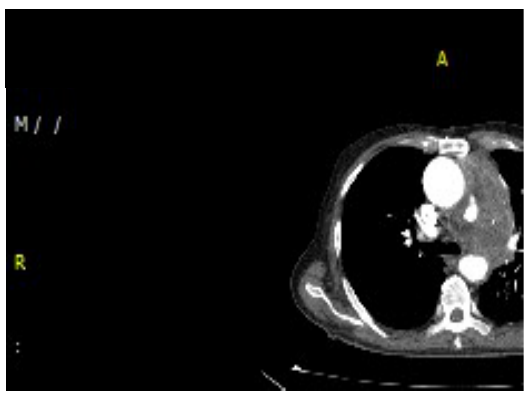
Figure 2. Mediastinal view of CT scan with contrast